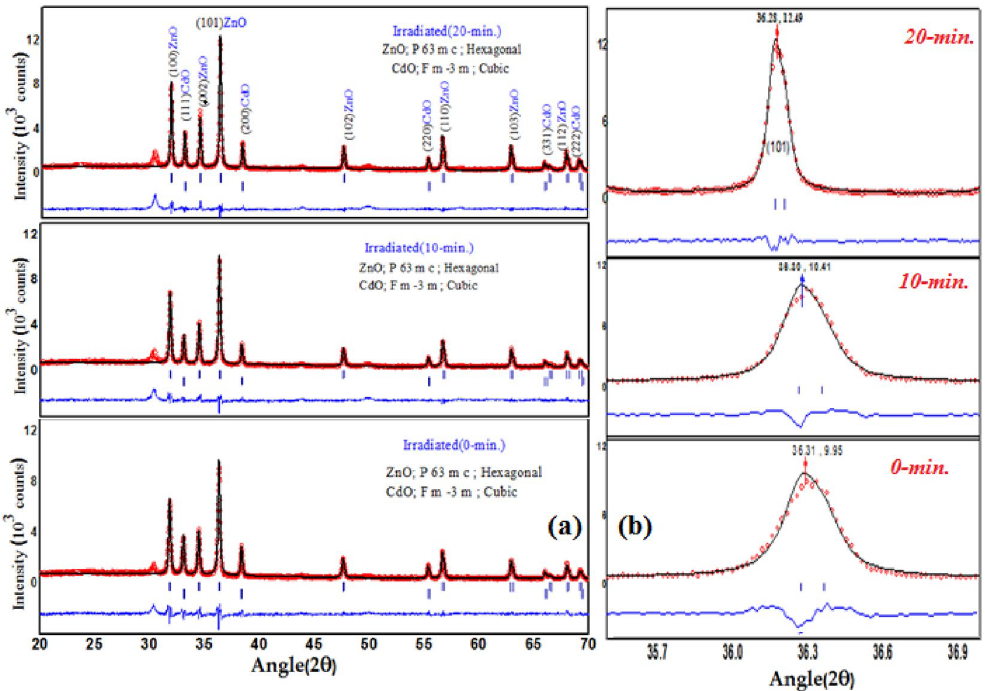
Figure 2. ( a ) Rietveld fiiting of XRD patterns of as-grown and irradiated ZnO-CdO coated films. ( b ) Enlarged area of 2θ from 35° to 37° peak corresponding to (101) plane showed shift under (10-min and 20-min) irradiation dose.